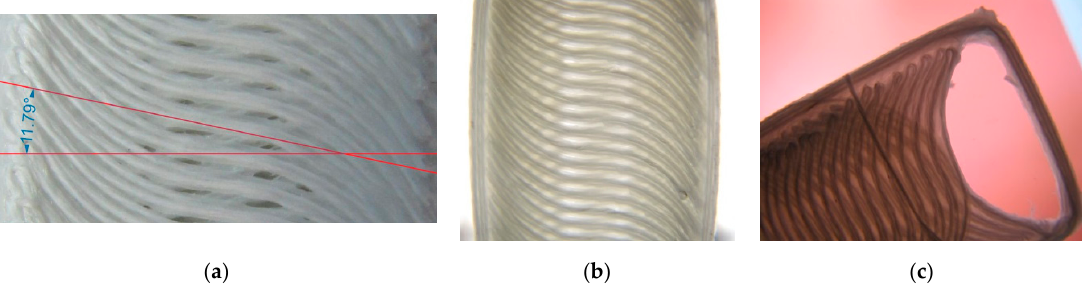
Figure 10. Printing composite samples with curved fibers. ( a ) The angle of the curve center at about 11 ° and ( b , c ) the angle of the curve center at 0 °.